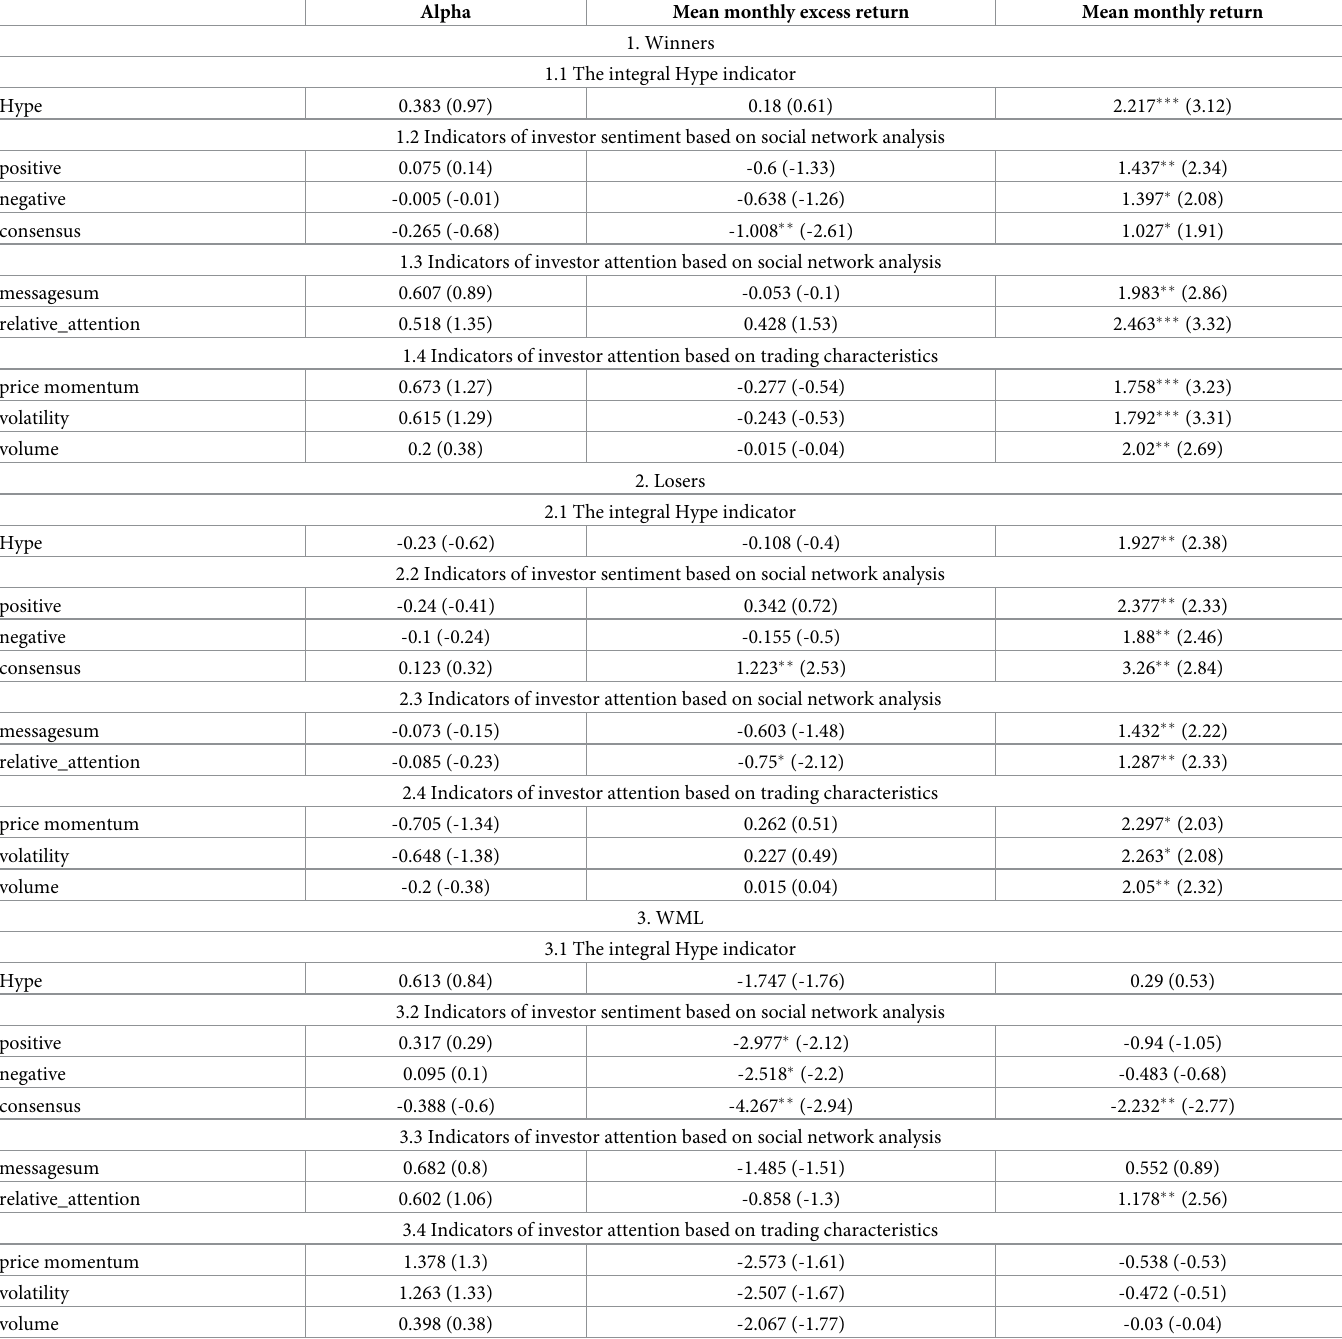
Table 6. The performance of the nine portfolios over a «long» period (6